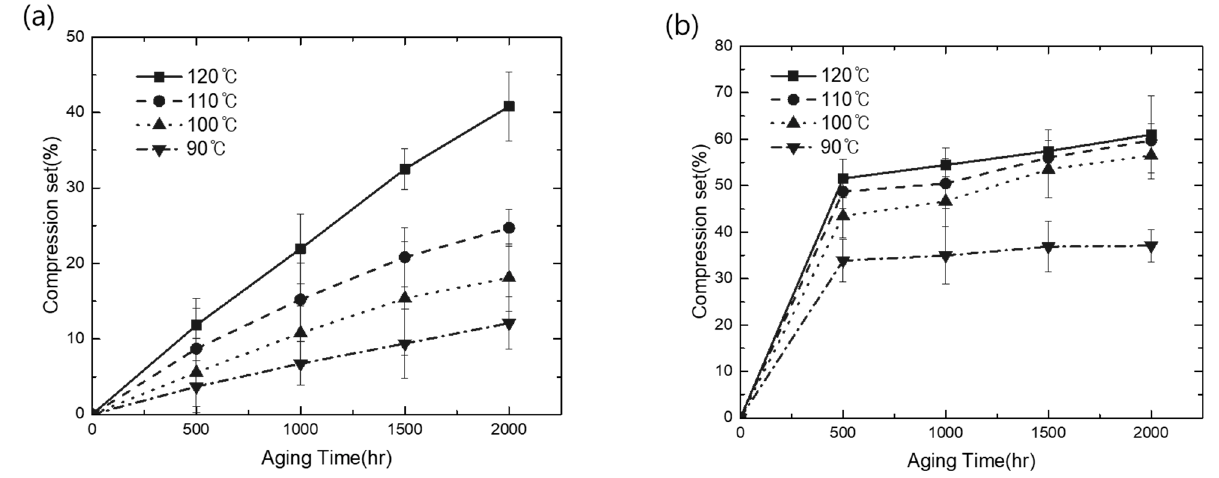
Figure 2. Comparison of CS thermal oxidation aging results: ( a ) CS changes of EPDM; ( b ) CS changes of TPV.